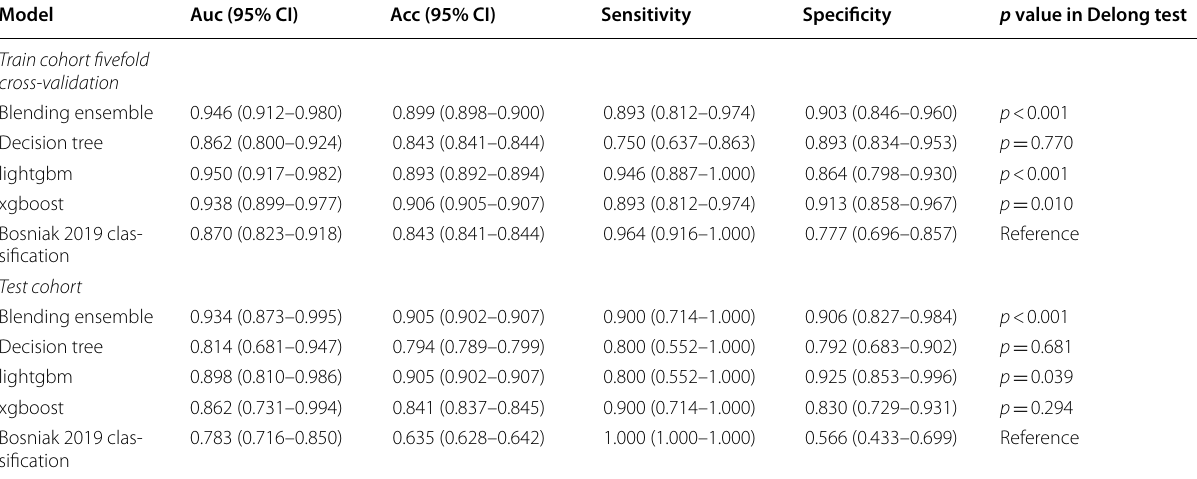
Table 2 The performance of four models and Bosniak‑2019 classification in external validation